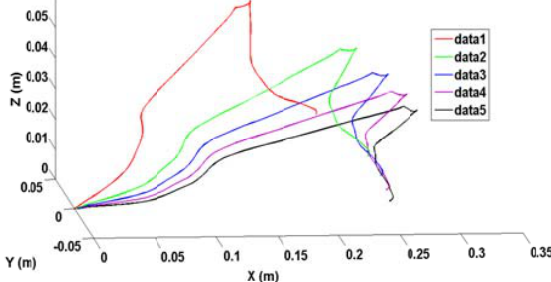
F Figure 9. T a and camera system is a stayed in X-Y ry started ar 0.0312, -0.1 distance trav s sorTag OEA 3. .2. Monito To o monitor sub eriments’ were we earing one Se fo od from a tab mo outh. When f arm tim tor clo osed-loop traj arm mrest, and fin ing tur en nding points w